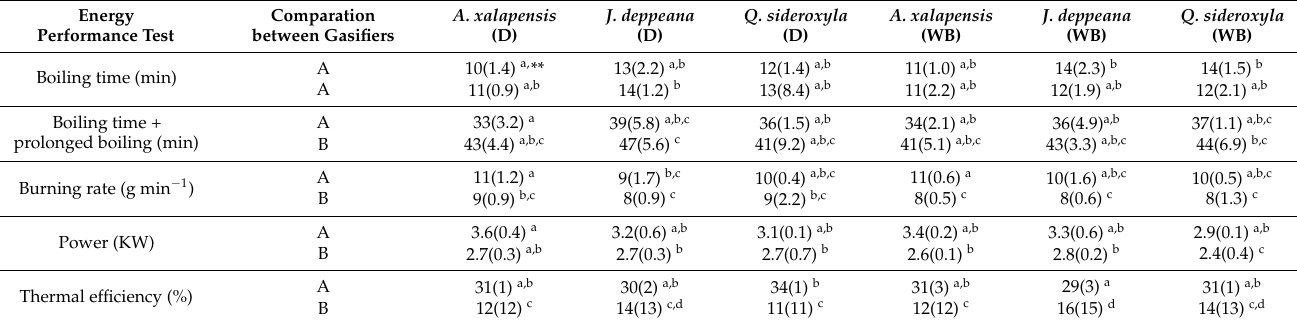
Table 5. Average energy performance of different types of pellets according to the standard ISO test. Energy Performance